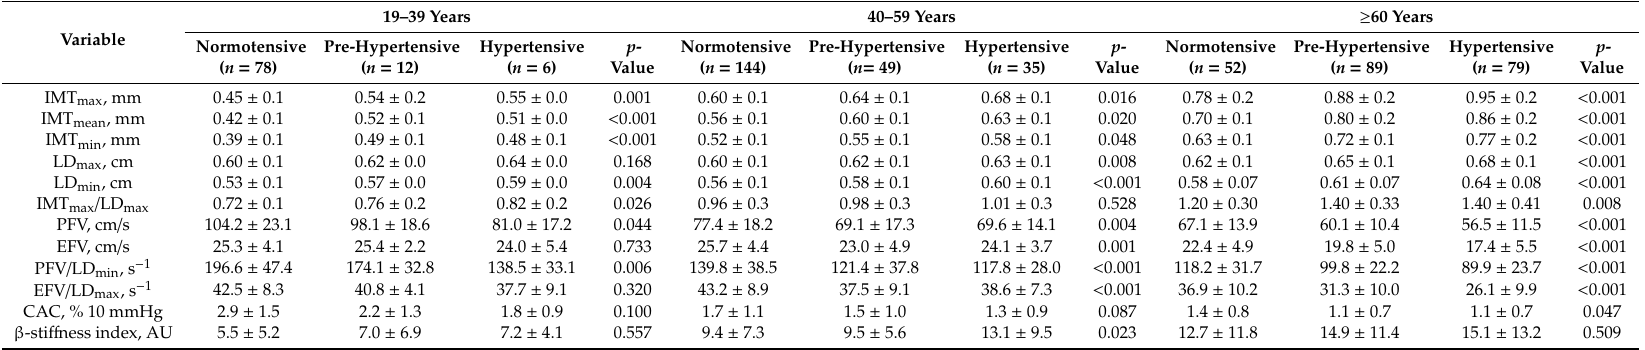
Table 4. Di ff erences in carotid arterial characteristics among groups according to the category of blood pressure and age. Variable